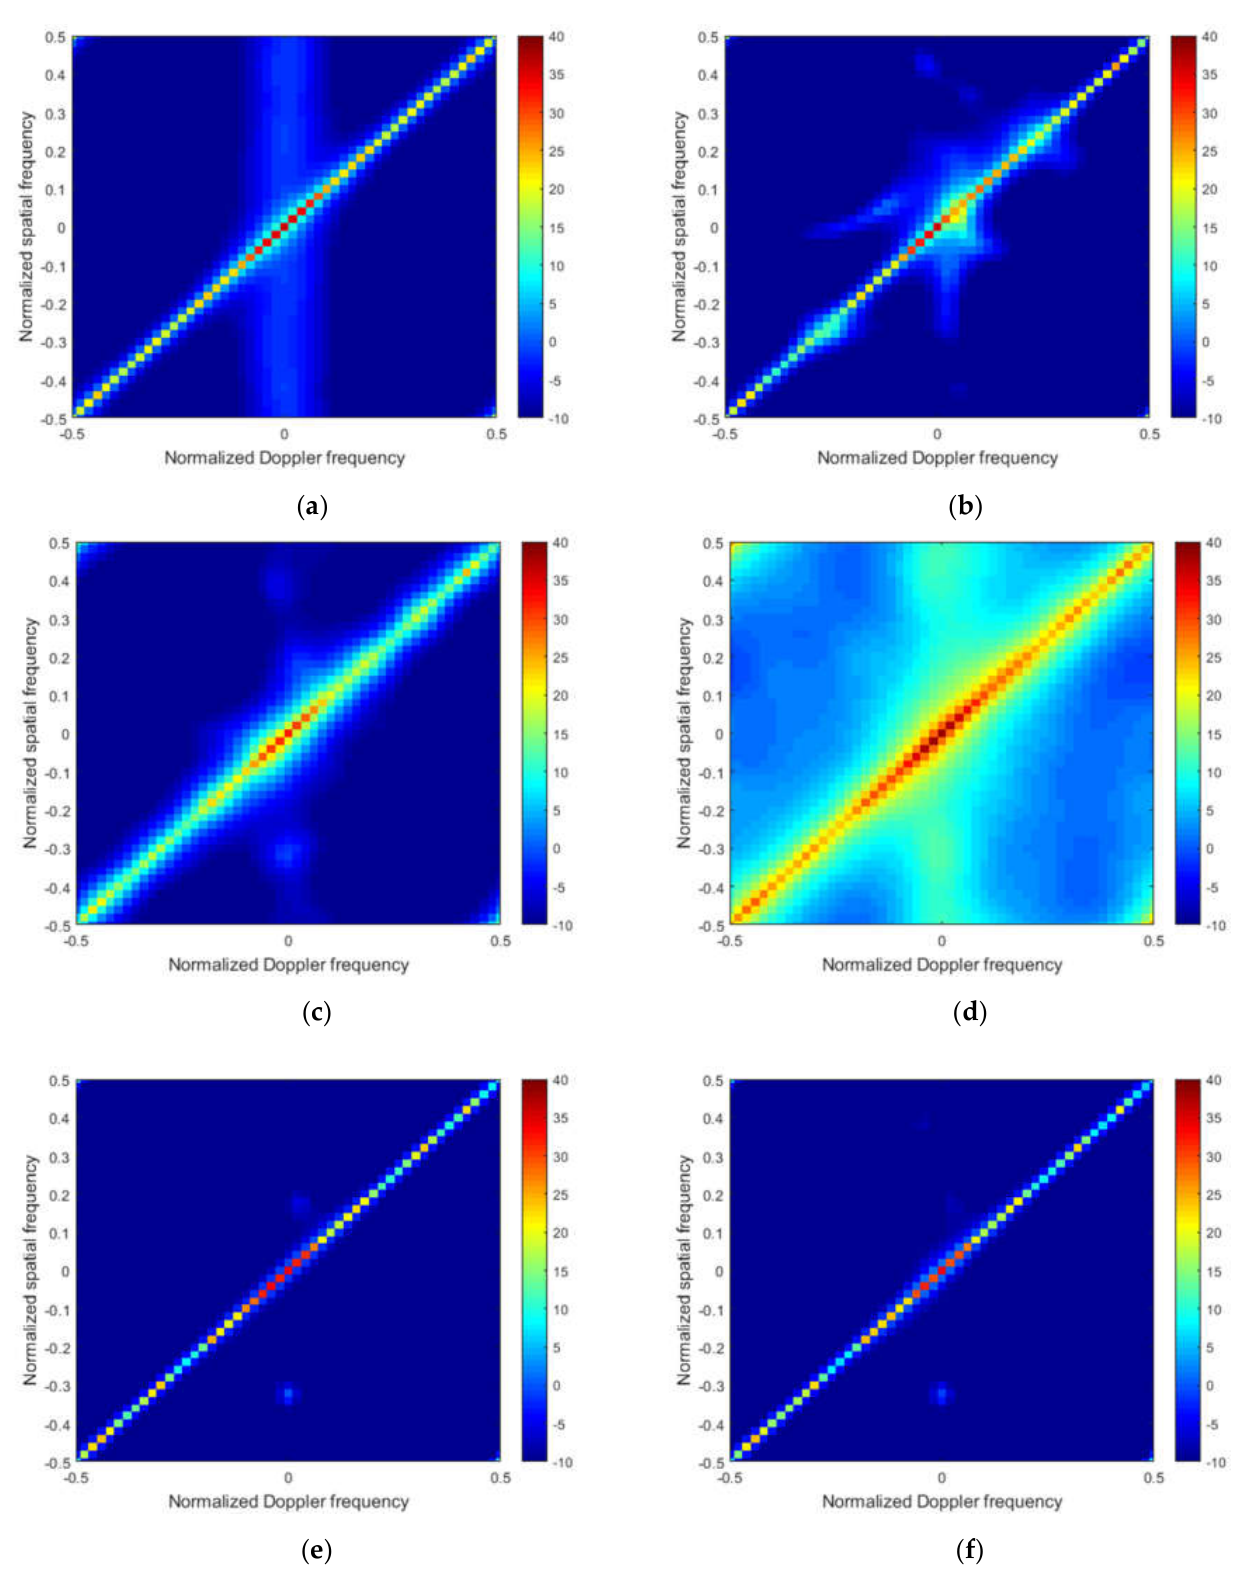
Figure 5. Capon spectrum of different methods with error. ( a ) the ideal capon spectrum; ( b ) the capon spectrum of M-OMP; ( c ) the capon spectrum of M-FOCUSS; ( d ) the capon spectrum of M-IAA; ( e ) the capon spectrum of M-SBL; ( f ) the capon spectrum of proposed method.